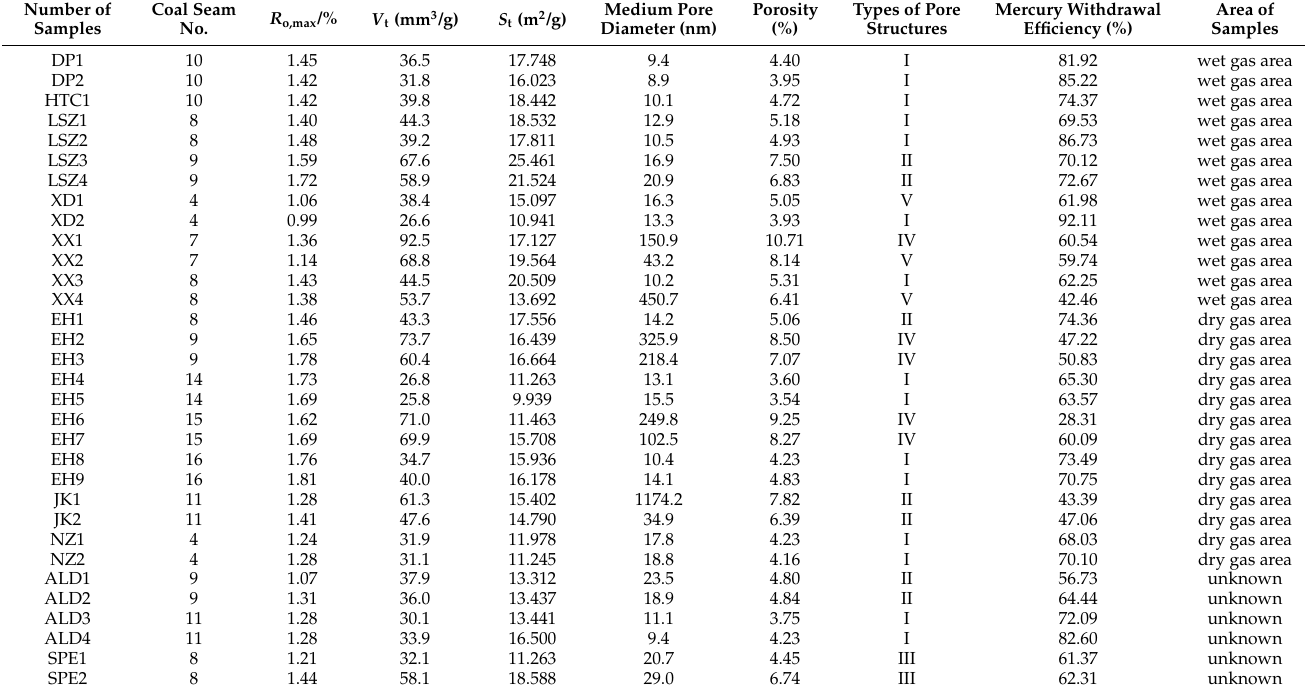
Table 1. Parameter statistics of pore structure of coal sample, Enhong syncline. Number of